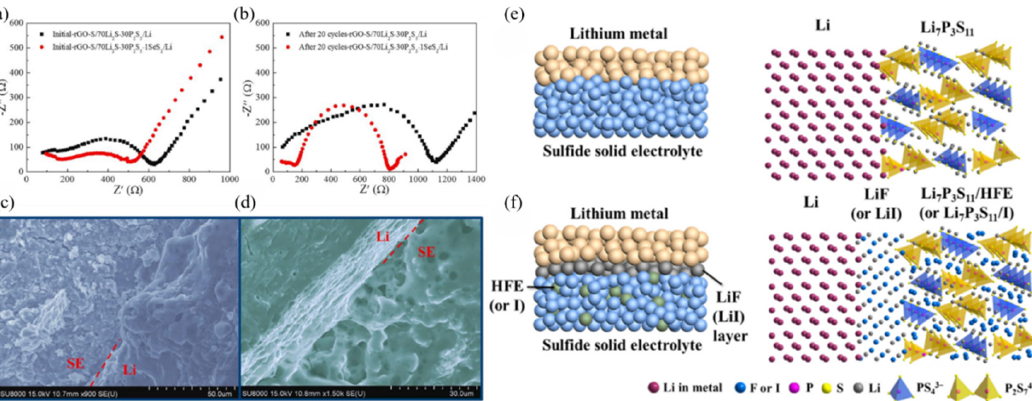
Figure 10. Nyquist plots of rGO/70Li 2 S-30P 2 S 5 /Li and rGO-S/70Li 2 S-29P 2 S 5 -1SeS 2 /Li ASSLIBs at 30 °C. Measurements were conducted ( a ) before and ( b ) after 20 cycles at 0.1 mA·cm − 2 ; SEM images of the interface between the ( c ) 70Li 2 S-30P 2 S 5 , ( d ) 70Li 2 S-29P 2 S 5 -1SeS 2 and Li in rGO-S/solid electrolyte/Li ba tt eries at 0.1 mA·cm − 2 for 100 charge–discharge cycles. Reprinted with permission from ref. [140]. Copyright 2019 Elsevier. Schematic diagrams of ( e ) Li/Li 7 P 3 S 11 interface of ASSLIBs and ( f ) modi fi ed interface with a uniform thin LiF (or LiI) interphase layer and HFE (or I solution) infi ltrated sul fi de electrolyte. Reprinted with permission from ref. [142]. Copyright 2018 Elsevier.